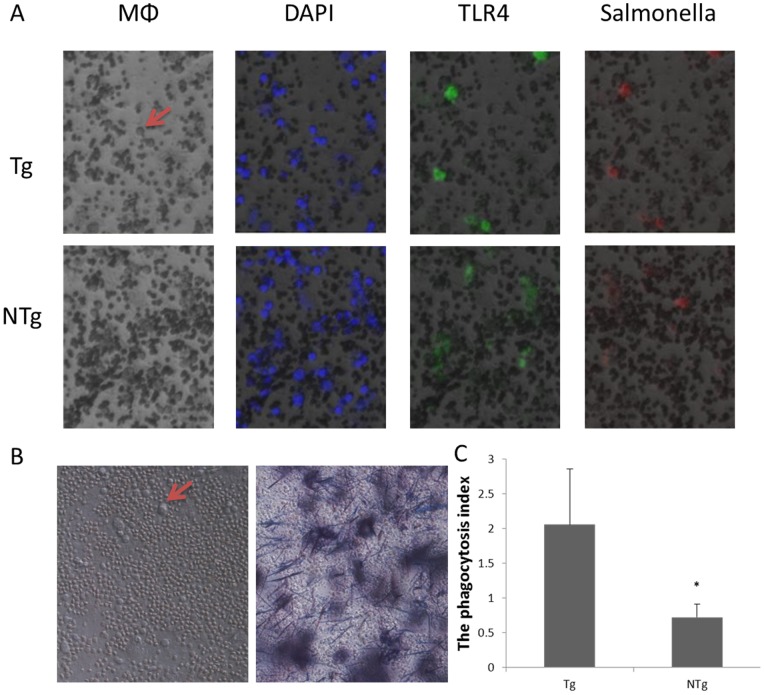
Phagocytosis and adhesion of monocyte/macrophage in Tg. A) monocytes/macrophages (arrows) are large cells (200×), stained with DAPI (blue), TLR4-FITC (green), and Rhodamine B label
Salmonella (red). B) The HCT8-MTT method was used to assess phagocytosis. C) The phagocytic index of transgenic group was higher than that of non-transgenic group. Tg  =  transgenic sheep, NTg  =  non-transgenic sheep. The results were means ± SE. *Different letters indicate significantly different values (P<0.05).